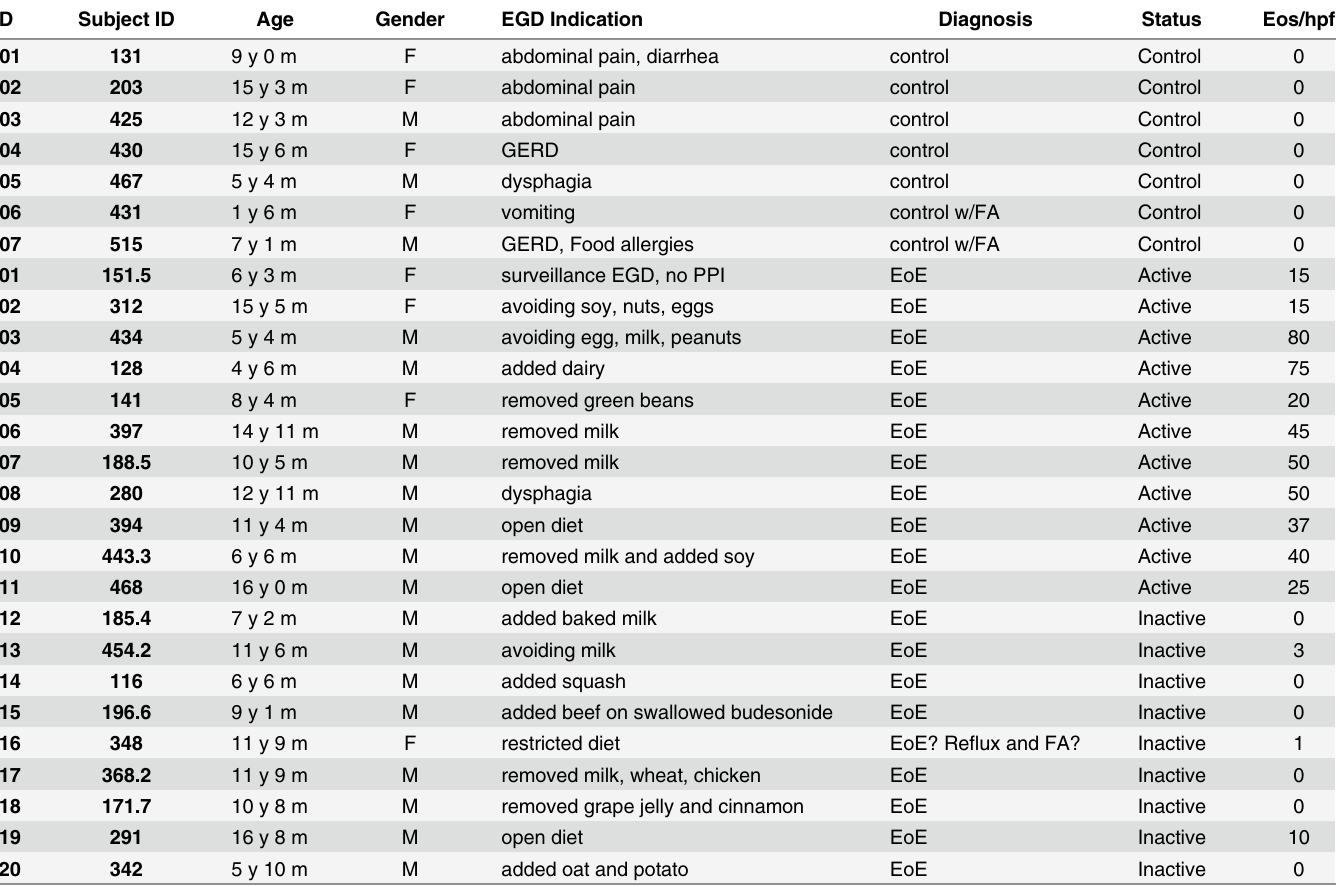
Table 1. Patient demographics, and allergy test